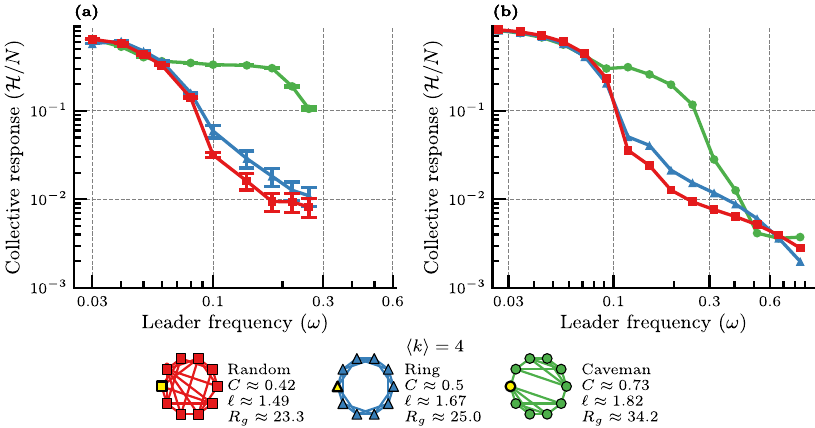
Fig. 3 Experimental analysis with a leader – follower networked robotic system networked by means of three topologies: “ Random ” , “ Ring ” , and “ Caveman ” with 〈 k 〉 = 4 and 9 + 1 agents ( “ Methods ” ). The graphs represent the network topologies used in the series of experiments, with the selected leader node depicted in yellow: a Experimental results of angular consensus dynamics (mean value and associated standard deviation; “ Methods ” ), b simulation results of the nonlinear angular consensus